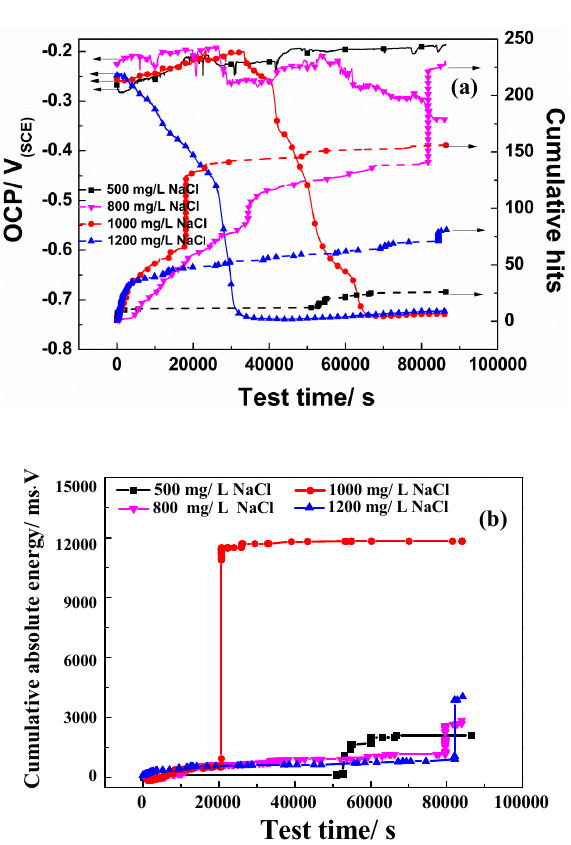
Figure 2. The open circuit potential (OCP) and AE monitoring of the pitting corrosion of carbon steel in NaCl + NaHCO 3 solutions: ( a ) OCP and cumulative hits versus time, ( b ) cumulative absolute energy versus time.